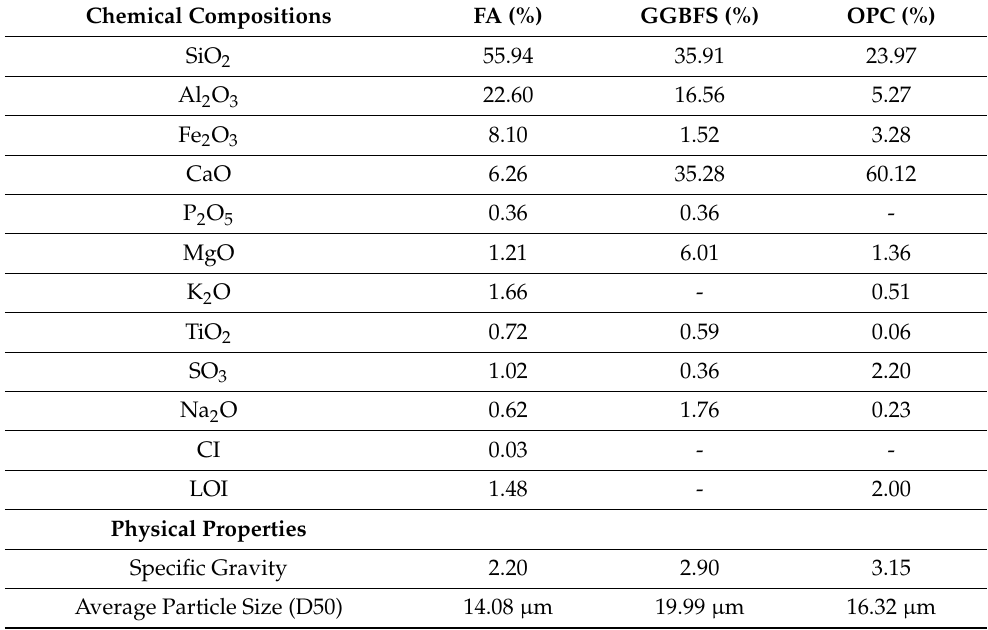
Table 1. Chemical compositions (%) and physical properties of Fly Ash (FA), Ground Granulated Blast Furnace Slag (GGBFS) and ordinary Portland cement (OPC) were obtained from the manufacturer. Chemical